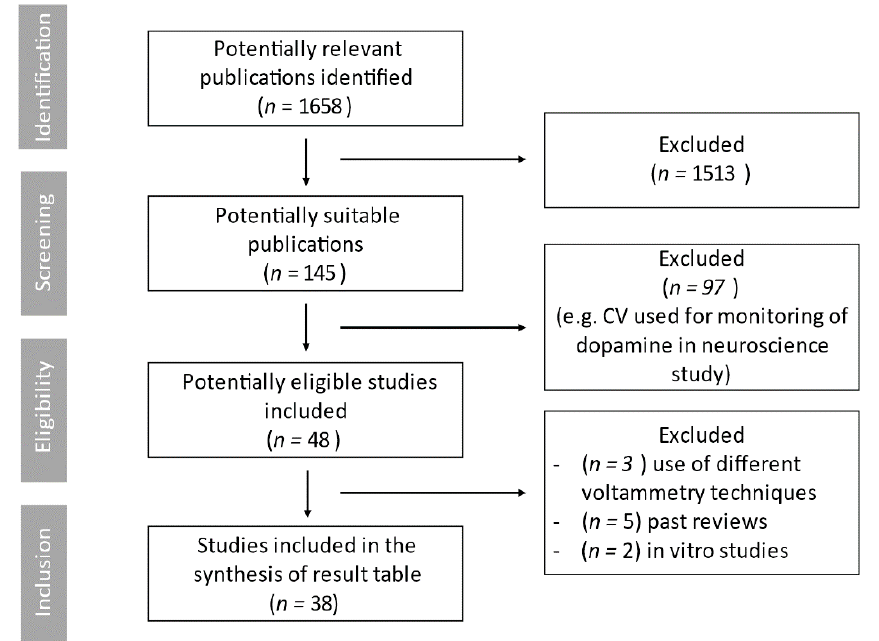
Figure 3. PRISMA flowchart for article identification & selection.